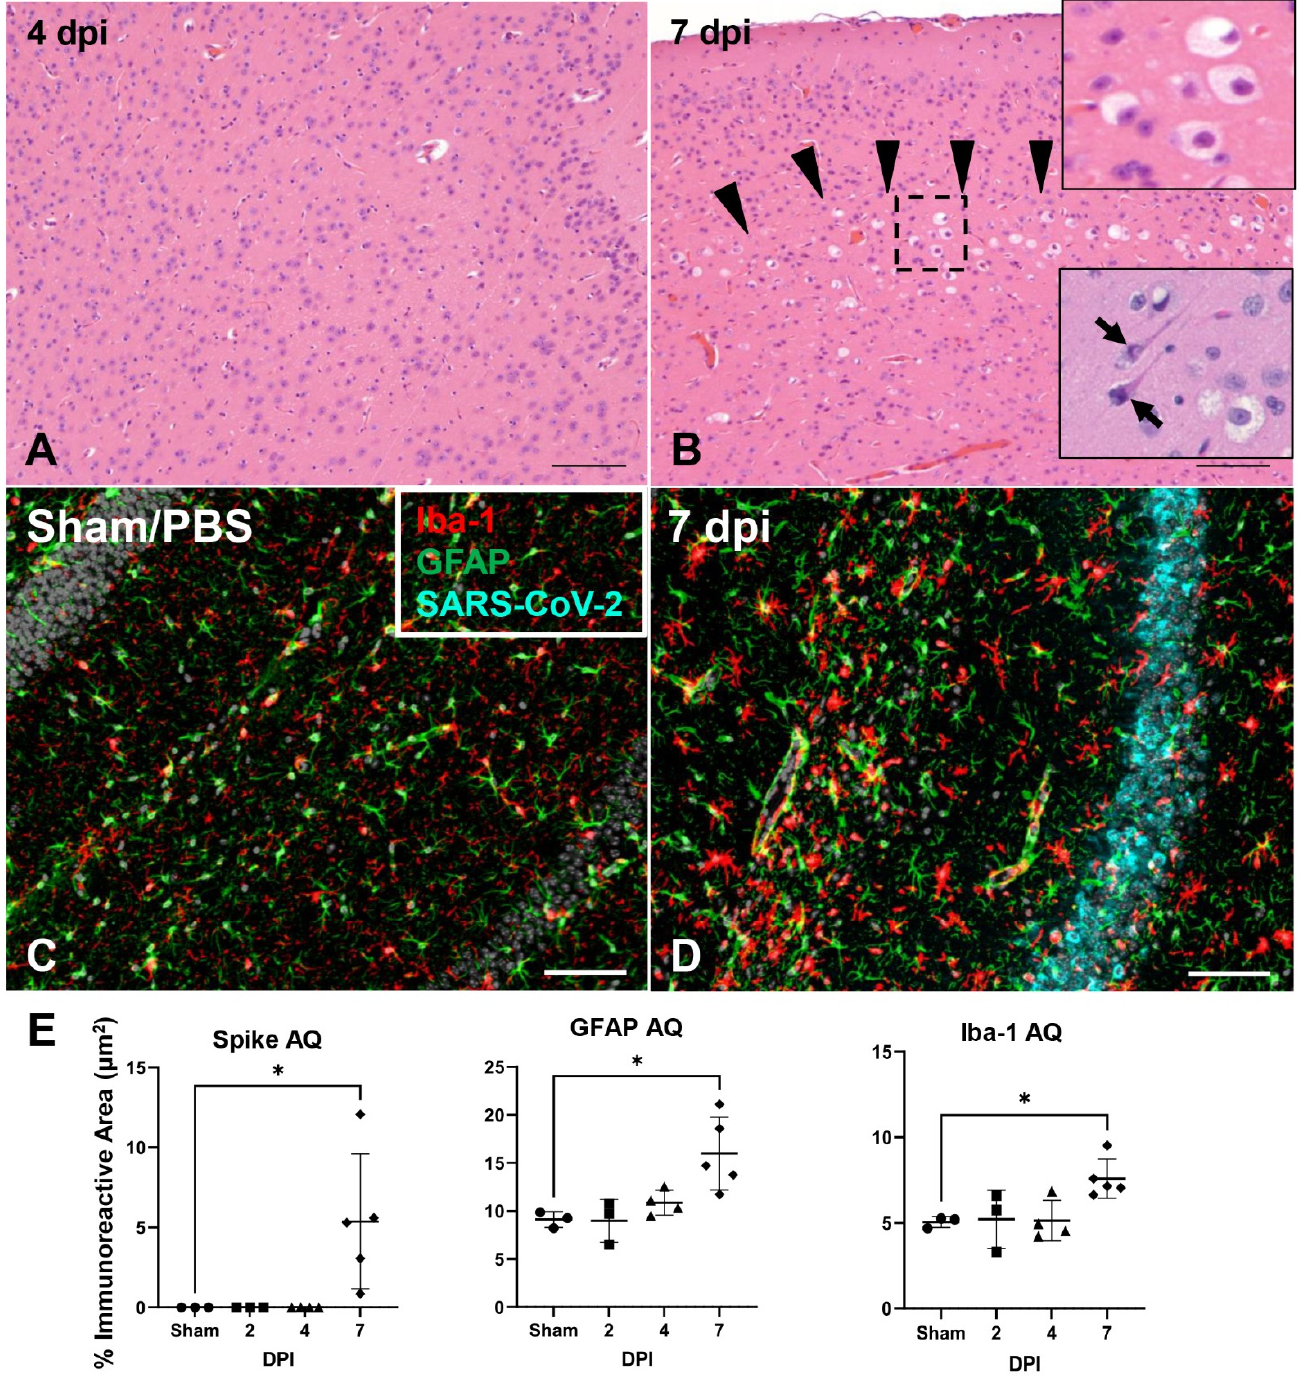
Figure 7. SARS-CoV-2-associated neuronal morphological changes, neuronal antigen abundance and glial response. Morphological changes in the brain were noted as early as 6 dpi ( A , B ) and were characterized by variable spongiosis ( B , arrowheads, and top inset) with neuronal degeneration and necrosis ( B , bottom inset and arrows) involving multiple areas within the cerebral cortex and elsewhere. ( C – E ) Quantification of 3-plex fluorescent IHC targeting SARS-CoV-2 Spike protein, astrocytes (GFAP) and microglia (Iba-1) in the brain of Sham/PBS mice and in inoculated mice (2, 4, 7 and 14 dpi). The amount of viral protein rapidly and markedly increased by 7 dpi, along with an intense astrocytic and microglial response ( C – E ). H&E, 100X, bar = 200 μ m. Multiplex IHC, 200X total magnification, bar = 100 μ m. One-way ANOVA; * p ≤ 0.05.